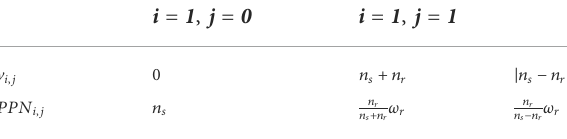
TABLE 1 Dominant harmonics excited by outer-layer ferrite PMs.